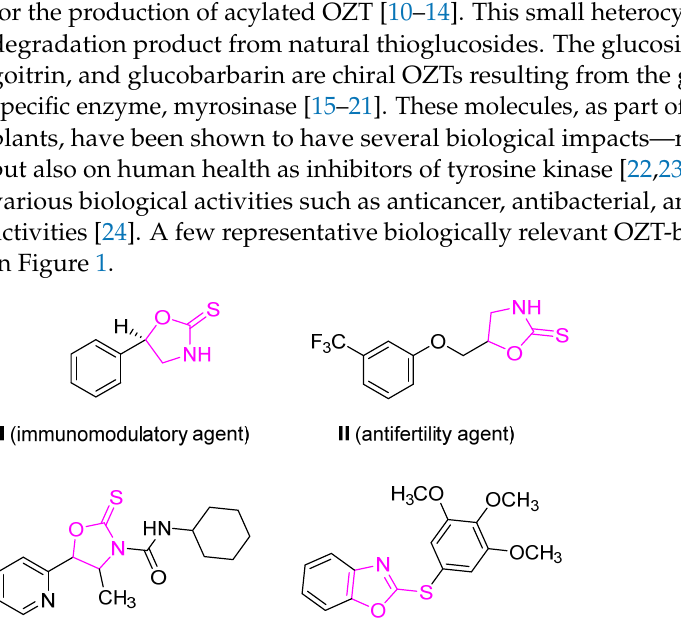
Figure 1. Biologically active compounds ( I–IV ) bearing the OZT scaffold